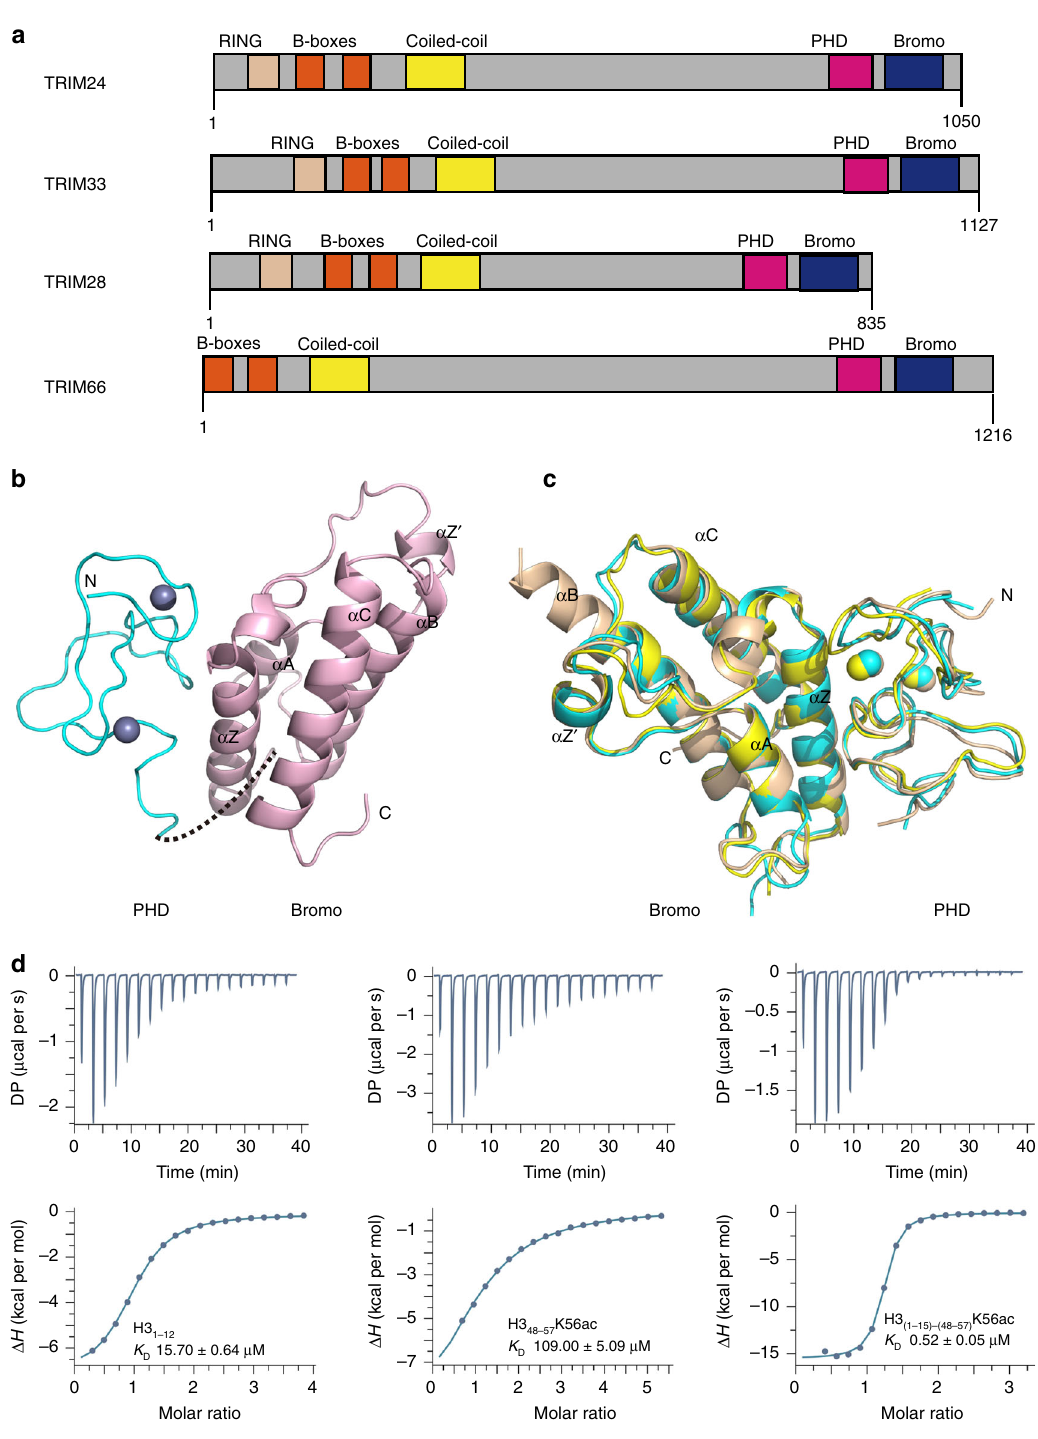
Fig. 1 The TRIM66 PHD-Bromodomain interacts with the unmodi fi ed H3 N-terminal and H3K56ac. a The domain architecture of human TRIM24, TRIM28, TRIM33, and TRIM66. B-boxes, B-boxes domain; Bromo, bromodomain; Coiled-coil, coiled-coil region; PHD, plant homeodomain; RING, RING- fi nger domain. b Crystal structure of the TRIM66 PHD-Bromodomain in its free state. The linker (dash line) is invisible in the structure. The PHD fi nger (in aquamarine) and Bromodomain (in light pink) are graphically shown. Two zinc ions of the TRIM66 PHD are shown as silver spheres. c Superposition of the crystal structures of the PHD-Bromo tandem domains of TRIM24, TRIM33, and TRIM66. TRIM24 (cyan; PDB code: 3O33; 2.0 Å), TRIM33 (wheat; PDB code; 3U5M; 3.1 Å), and TRIM66 (yellow; this study; 2.1 Å) in their free state. d ITC titration: titrating TRIM66-WT 965-1160 with various histone H3